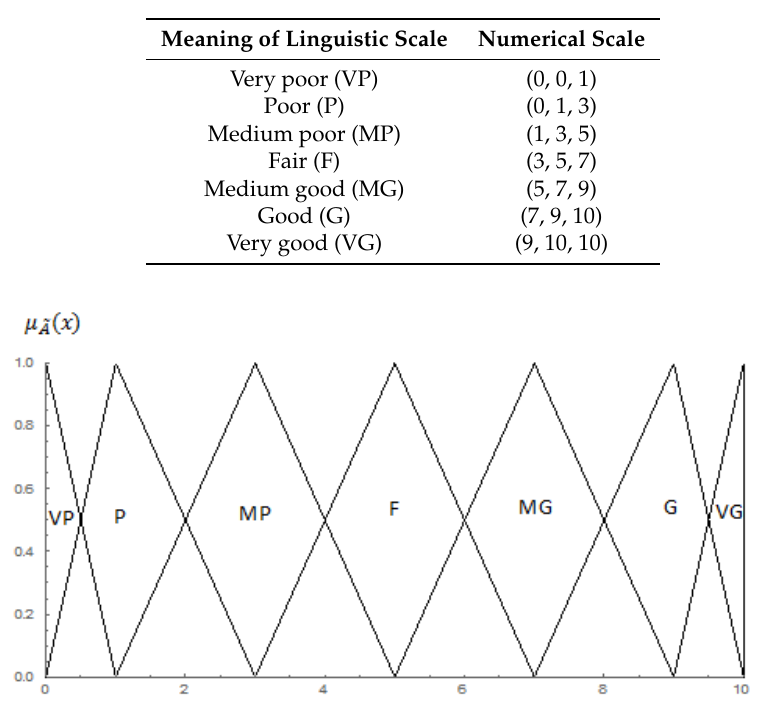
Table 2. Linguistic variables for the alternative performance.